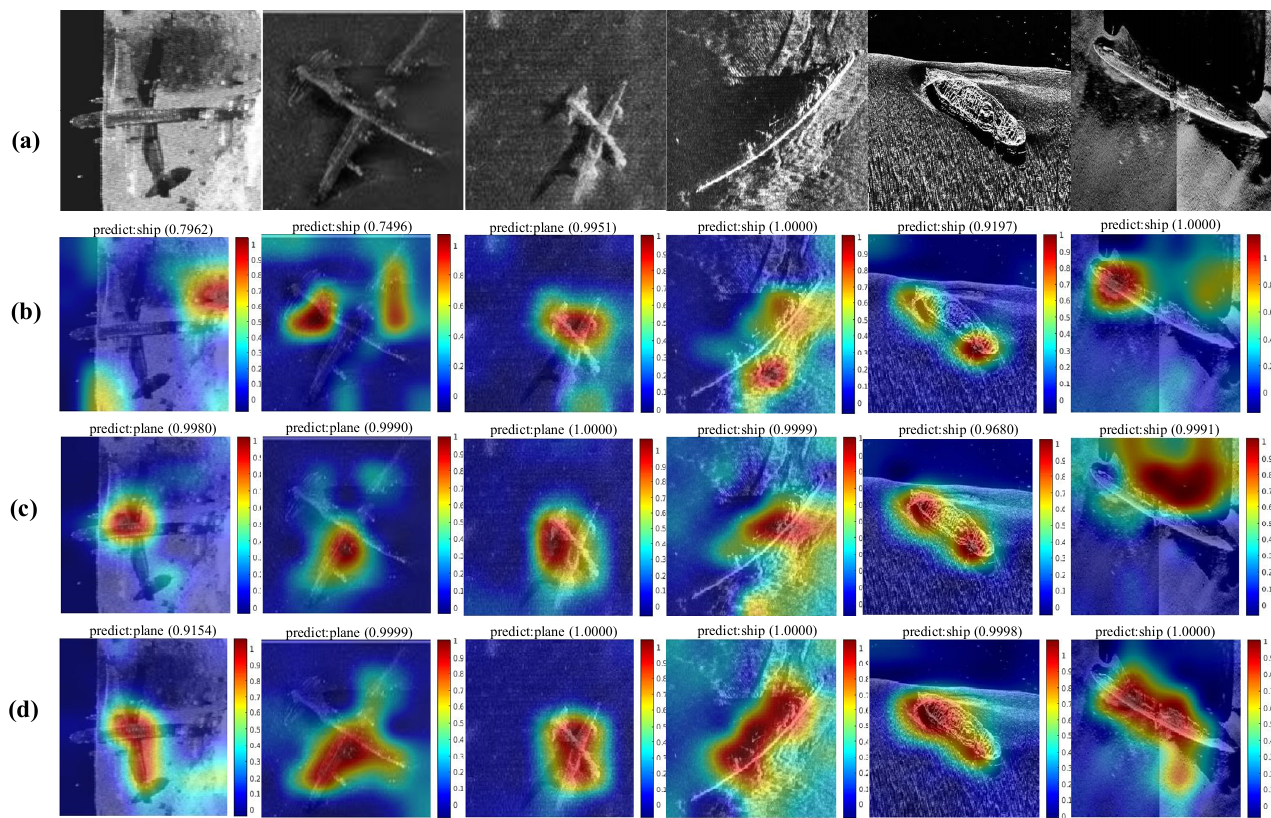
Figure 13. Class activation heatmaps using different methods: ( a ) SSS image samples ( b ) Heatmaps using directly fine-tuning; ( c ) Heatmaps using MDCTL; ( d ) Heatmaps using MDCTL with MSRAM.